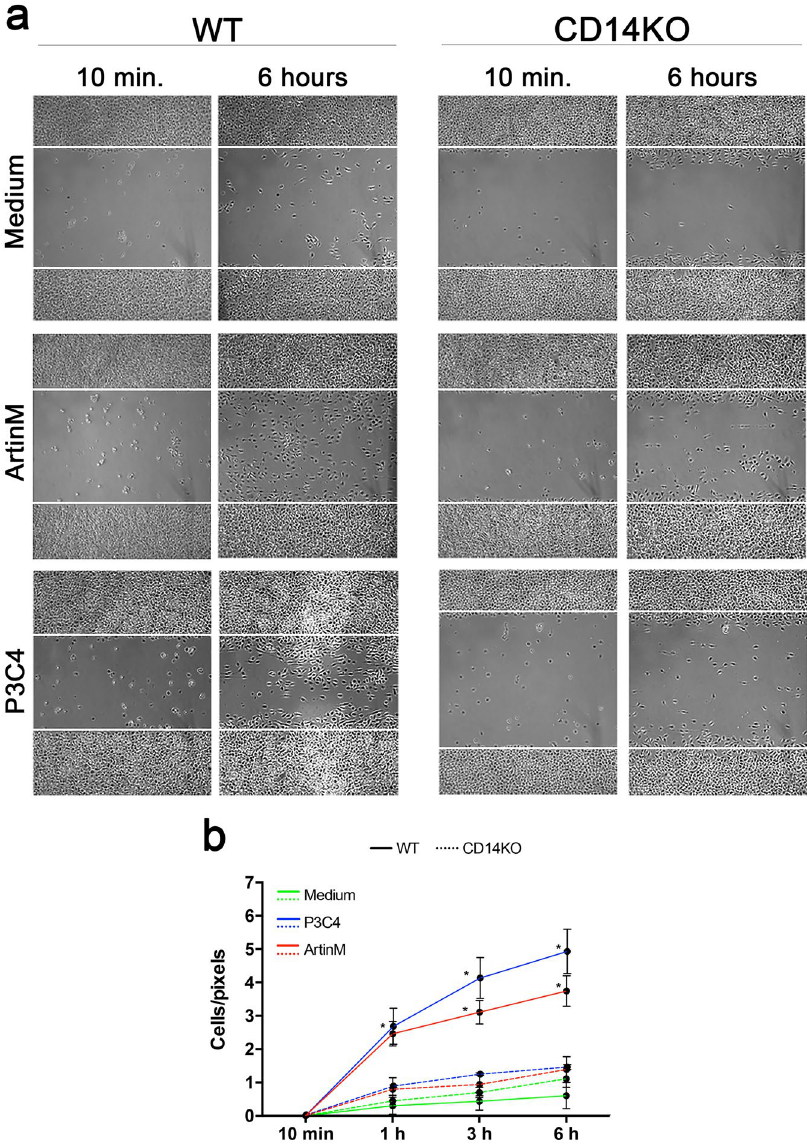
Figure 3. Macrophage migration induced by ArtinM is inhibited in the absence of CD14. Macrophages (1 × 10 6 /well) from WT and CD14 KO mice were assayed for migration in a wound healing model. ( a ) Cell monolayers were scratched (bounded by white line) and stimulated with ArtinM (2.5 µ g/mL), P3C4 (1 µ g/mL), or medium. Images of the scratch wounds were acquired at 10 min and 1, 3, and 6 h after stimulation. ( b ) Cells migrating to the scratched area, as shown in panel A, were measured and plotted in graphs (cells/pixels) at each time point. The macrophage migrations were compared among medium (green line), WT (continuous line), and CD14 KO (dotted line) macrophages and between WT and CD14 KO macrophages stimulated with ArtinM (red line). P3C4 (blue line) was used as the positive control. The data are shown as means ± SEM of independent experiments. * p < 0.05, according to one-way analysis of variance and Bonferroni’s